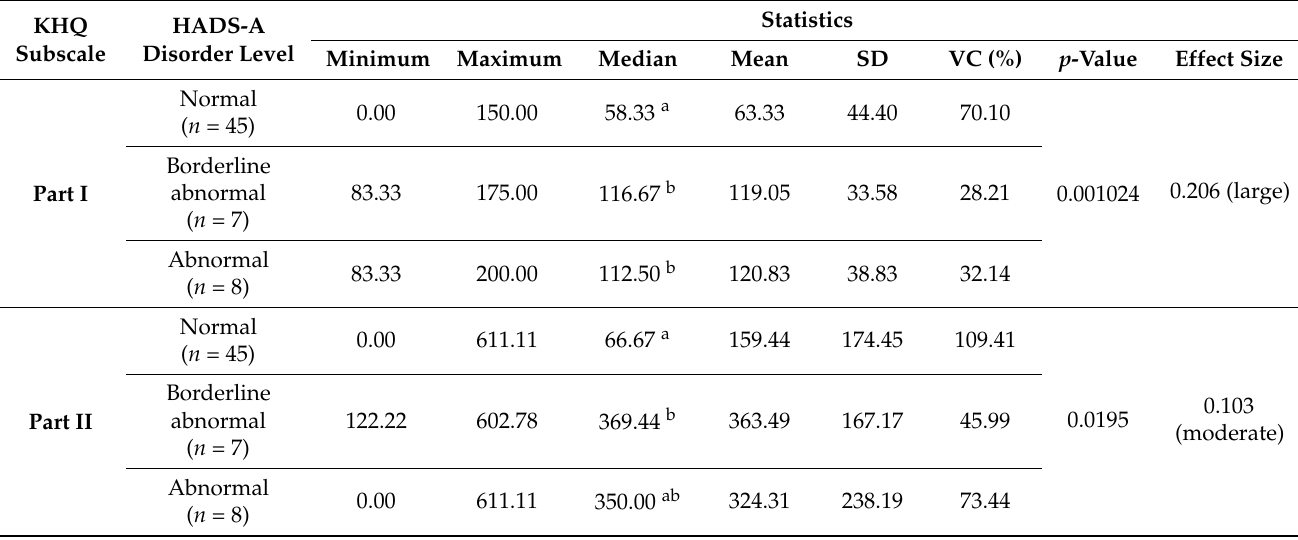
Table 6. KHQ—Parts I, II, III sub-scale scores for women 12 months after the surgery, with different disorder stages defined based on the HADS-A